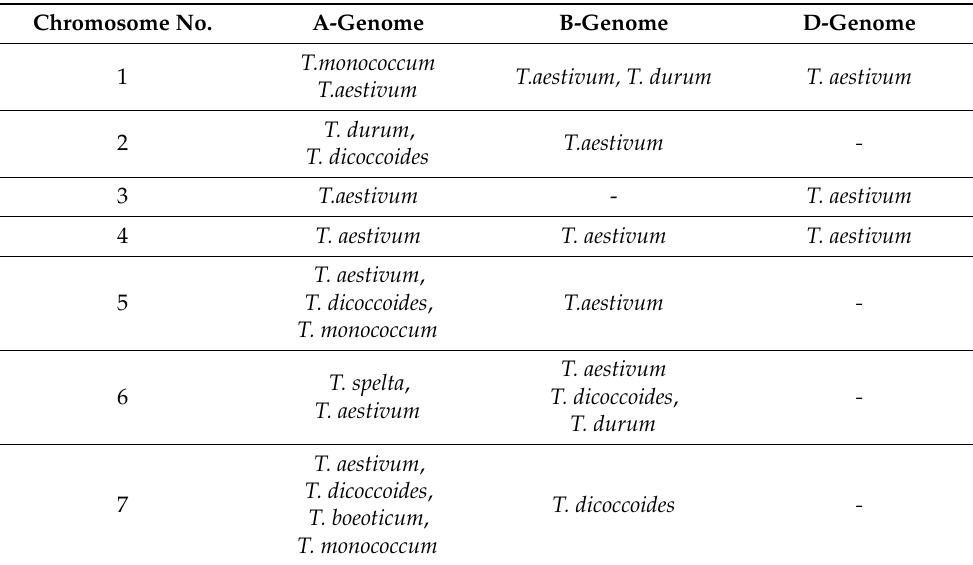
Table 4. QTLs identified on different chromosomes in T. aestivium and its related